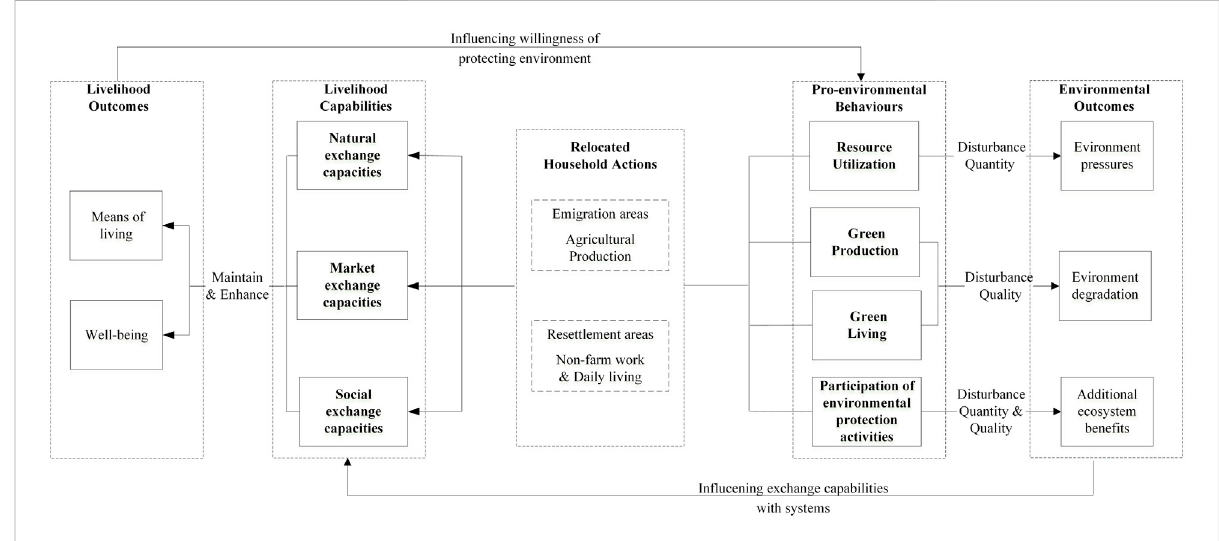
FIGURE 1 The conceptual framework of livelihood capabilities, pro-environmental behaviours and “ livelihoods – environment ” links in the ARSP